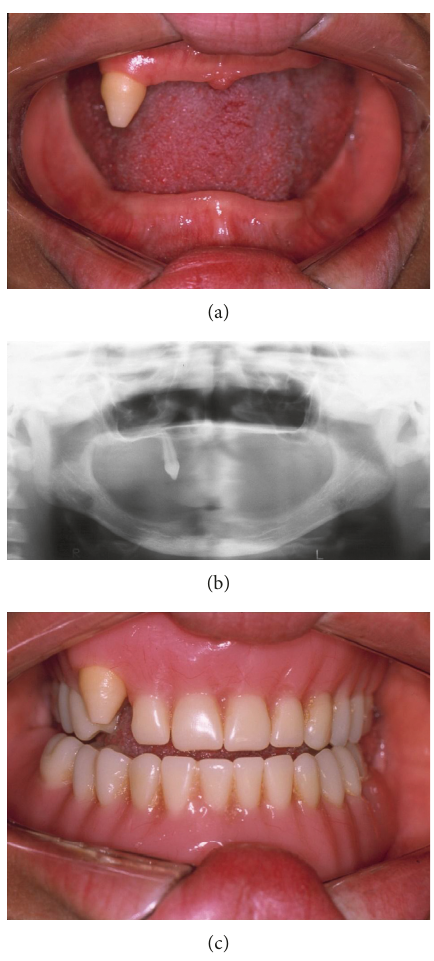
Figure 5: Patient 2. Agenesis of almost all permanent teeth, except the 13th tooth, underdeveloped alveolar ridge with “knife-edge” shape (a and b) and prosthodontic rehabilitation with the use of upper and lower dentures